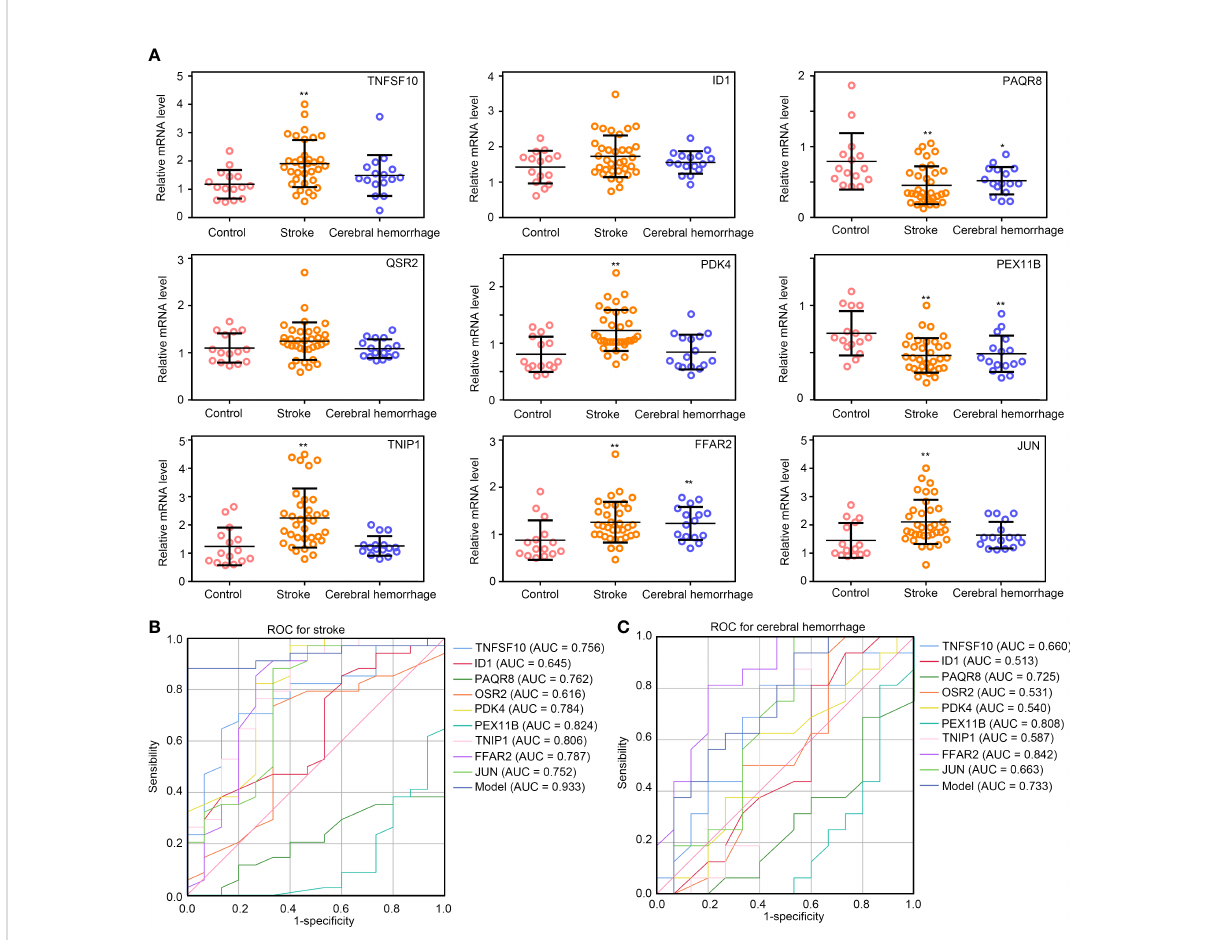
FIGURE 6 Validation of the diagnostic model in IS and CH samples. (A) The relative expression levels of TNFSF10, ID1, PAQR8, OSR2, PDK4, PEX11B, TNIP1, FFAR2, and, JUN in healthy controls, patients with IS and, patients with CH; (B, C) ROC curve analysis of TNFSF10, ID1, PAQR8, OSR2, PDK4, PEX11B, TNIP1, FFAR2, JUN, and diagnostic model constructed by these combines gene expression levels in IS and CH. **P<0.01;